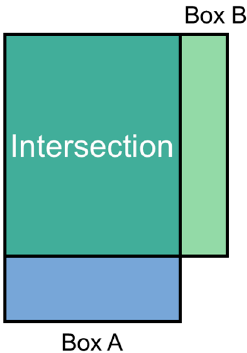
Figure 7. Positioning of bounding boxes for the intersection over union (IoU) calculation. The bounding boxes are those included in the training dataset. Based on this position, IoU with bounding box A and B was calculated, and the result was used for the clustering in the next step.